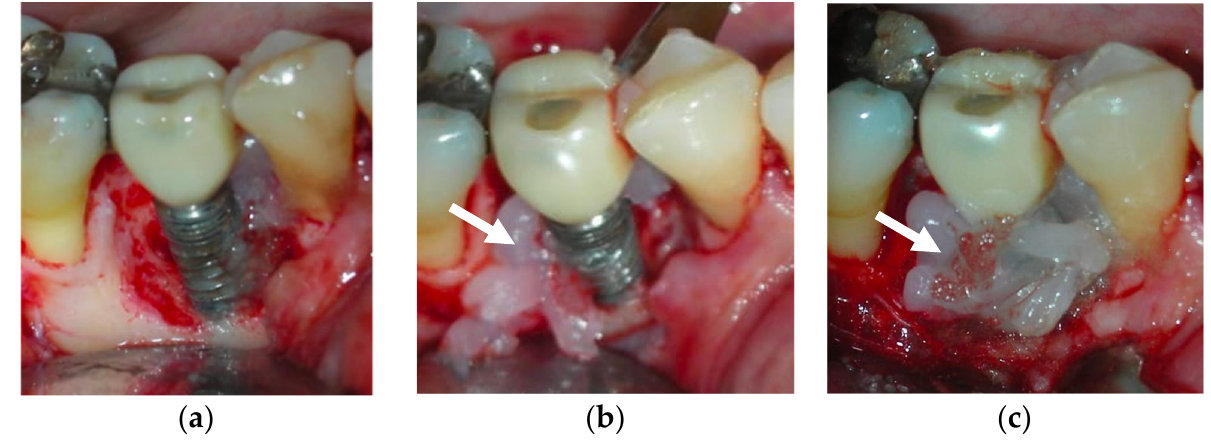
Figure 4. After debridement at the peri-implant site ( a ), blue ® m was applied ( b ) and was kept on the site for 5 minutes ( c ), followed by irrigation with saline. The white arrows point to the blue ® m gel.